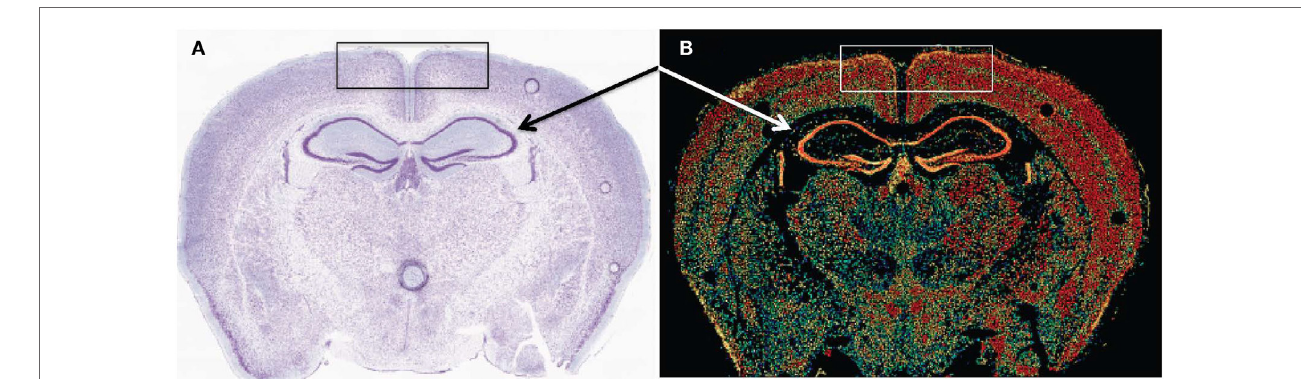
and red, signify high expression, cooler colors, such as green and blue, indicate low expression, and black indicates undetectable expression. A comparison of the two micrographs shows that cathepsin B is intensely expressed in the hippocampal neuronal cell layer (arrows) and in the cortex (box). Figures taken from the Allen Brain Institute web site http://www.